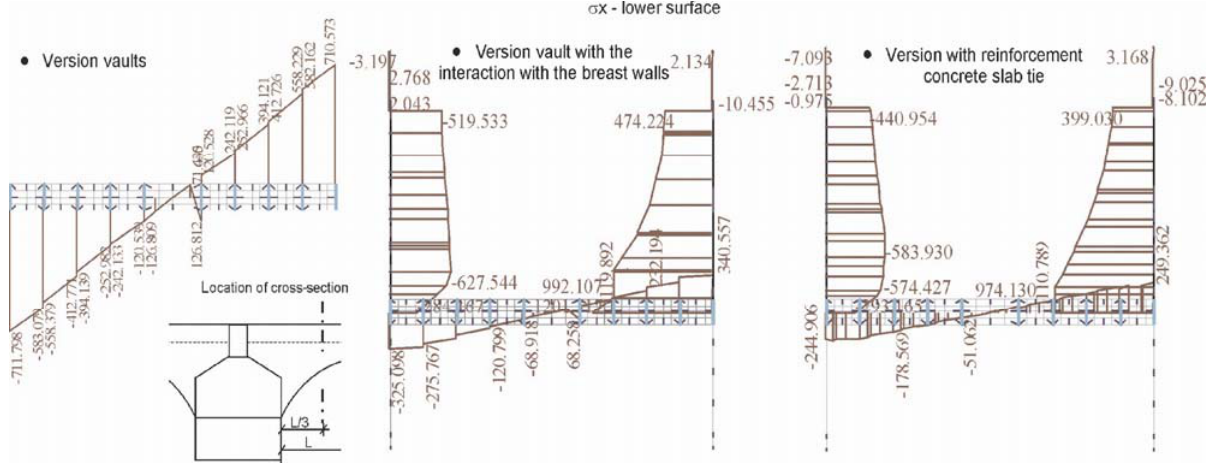
Fig 13. Scheme of course of normal stresses σ x (longitudinal) on lower vault surface (in 1/3 of vault span) at bridge pier shift by 10